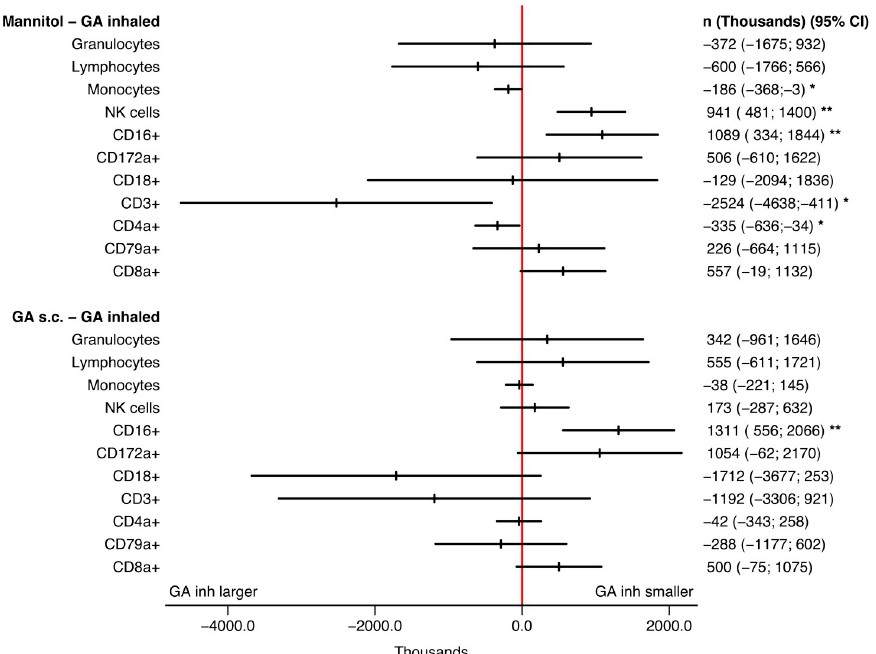
Fig 2. WBC counts by flow cytometry (mean, 95% CI). Change in effect (POST—PRE) in blood cell counts compared for mannitol and GA s.c. vs. GA inhaled. Effect (POST—PRE) is the increase in blood cell count for mannitol, GA s.c., and GA inhaled. The effects are compared as differences between mannitol and GA inhaled, as well as differences between GA s.c. and GA inhaled. The red line at zero should be within the shown confidence intervals if there are no difference between mannitol and GA inhaled (above); or GA s.c. and GA inhaled (below). � p < 0.05; �� p <